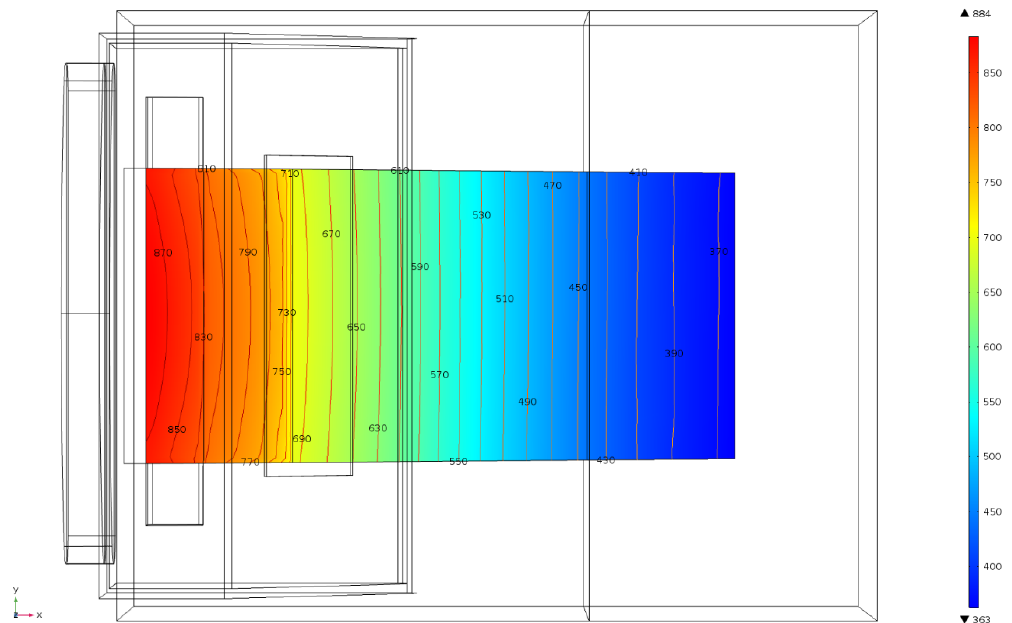
Figure 5. A contour plot of the temperature of the strip (°C ) . Gas inlet position: surface A in Figure 2, Q = 2.66 Nm 3 /h, Strip velocity = v Strip ( < 0.17 m/s ) .